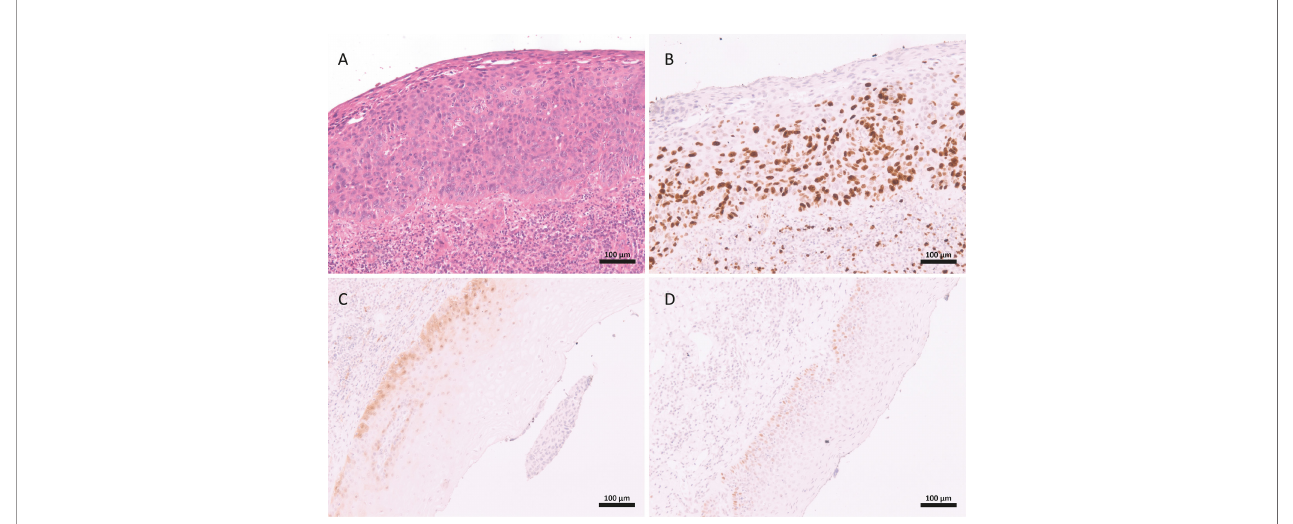
FIGURE 2 | Features of Penile intraepithelial neoplasia in the glans of a patient with leiomyosarcoma. Dysplastic epithelial cell in all squamous layers (A) . Immunohistochemistry staing for: Ki67 in suprabasal layers (B) , p16 (C) and p53 (D)